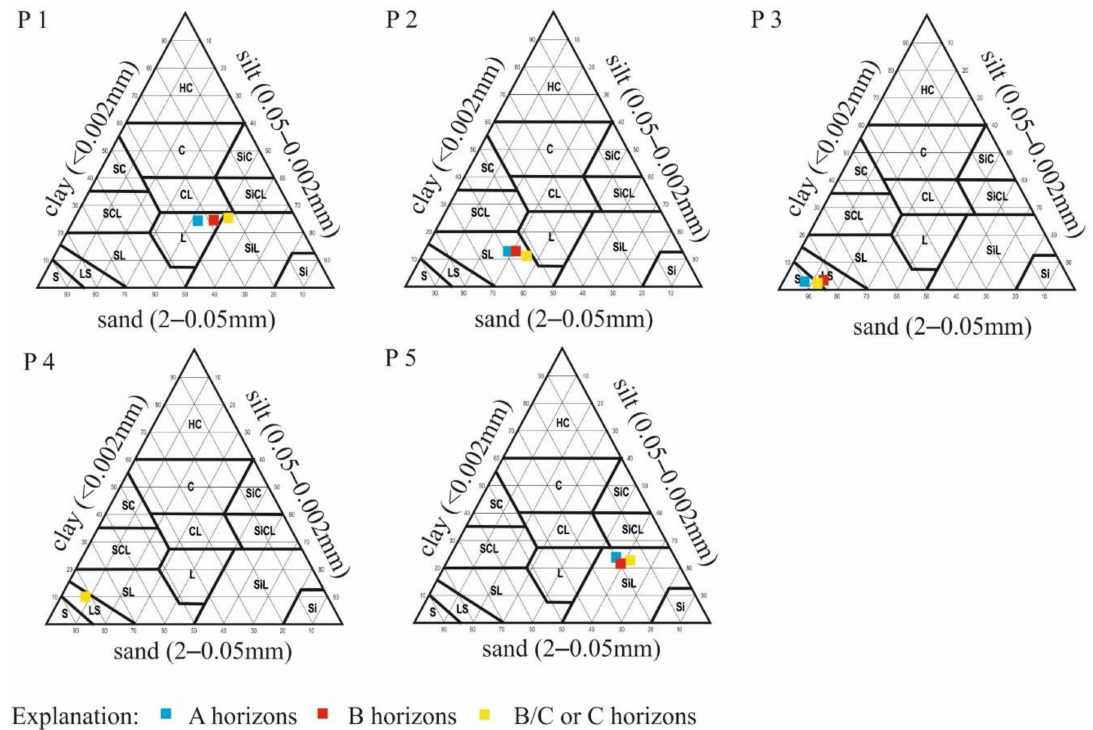
Figure 3. Particle size (mm) distribution (%) of studied